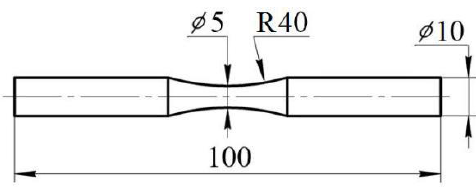
Figure 1: Specimen geometry (in